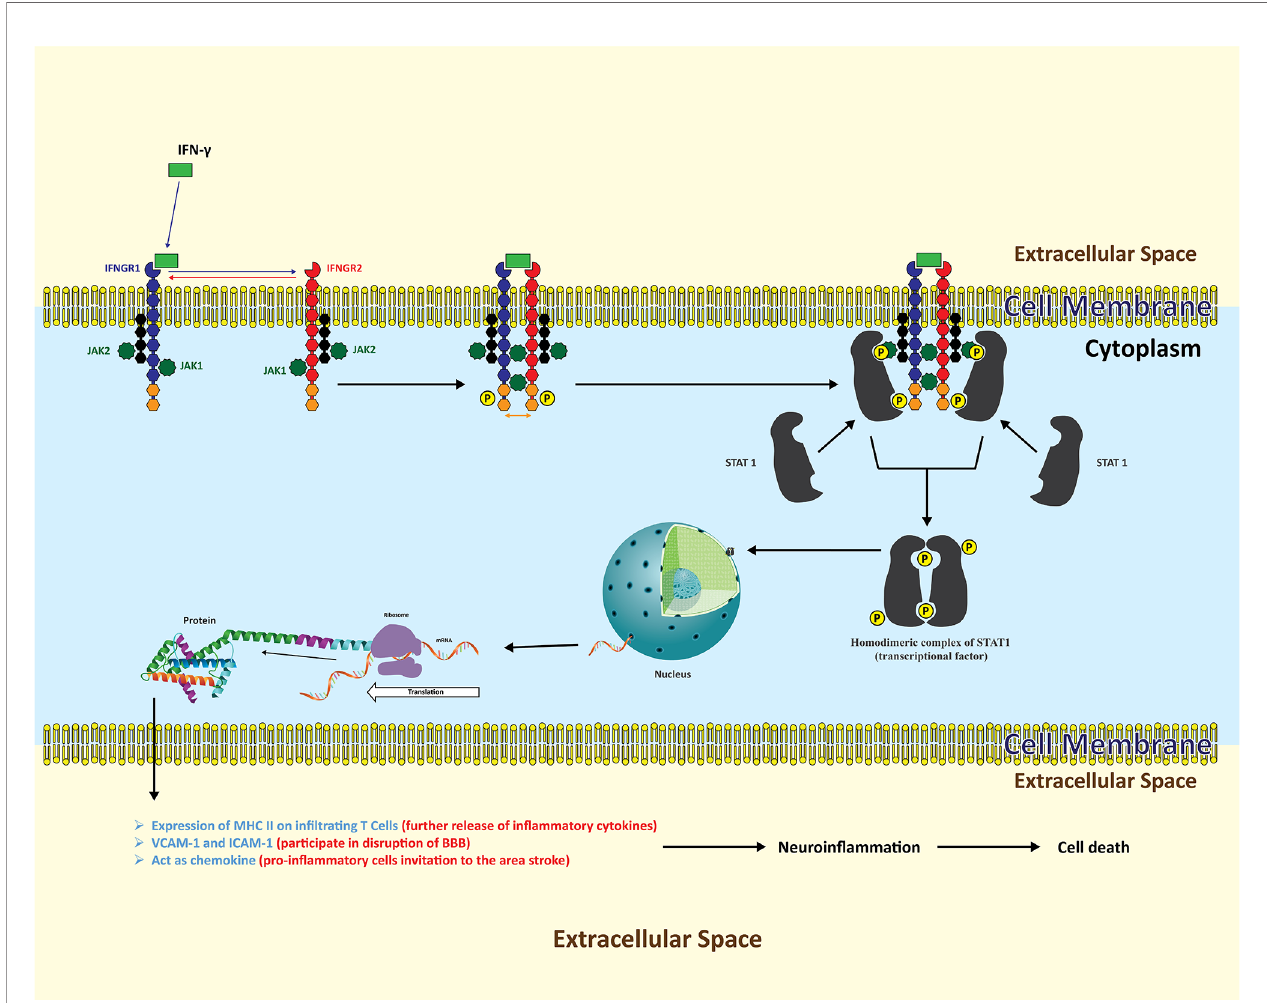
FIGURE 3 | The neuroin fl ammatory cascades of INF- g following ischemic insult. Resident astrocytes as well as in fi ltrating T lymphocytes are the key sources of INF- g . Following release, INF- g binds to transmembrane INFGR, which is further composed of two subunits, INFG1 and INFG2. Each receptor subunit of INFGR is further composed of two different proteins, with each bound to Jak1 and Jak2 respectively. INF- g binding with INFG1 part brings INFG2 in to proximity with INFG1 in such a way that, intracellularly, Jak1 and Jak2 phosphorylate each other ’ s two receptor domains. These receptor domains now act as docking points for STATs to bind with respective JAKs. The activated STAT dissociates and forms a homodimeric complex functioning as a transcription factor inducing the expression of variety of protein signals in various cell types. In cerebral ischemia, upregulated proteins are adhesion molecules on a variety of cells that play their role in the disruption of the BBB and the in fi ltration of leukocytes, along with proliferation of pro-in fl ammatory